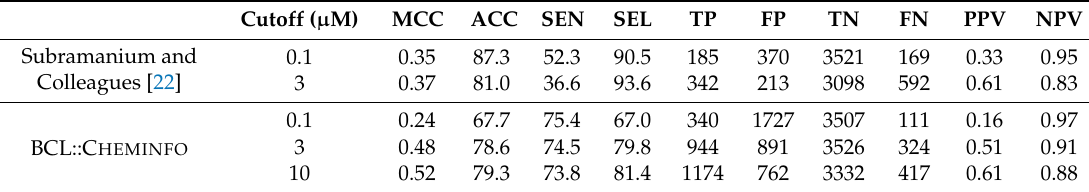
Table 2. Comparison of model